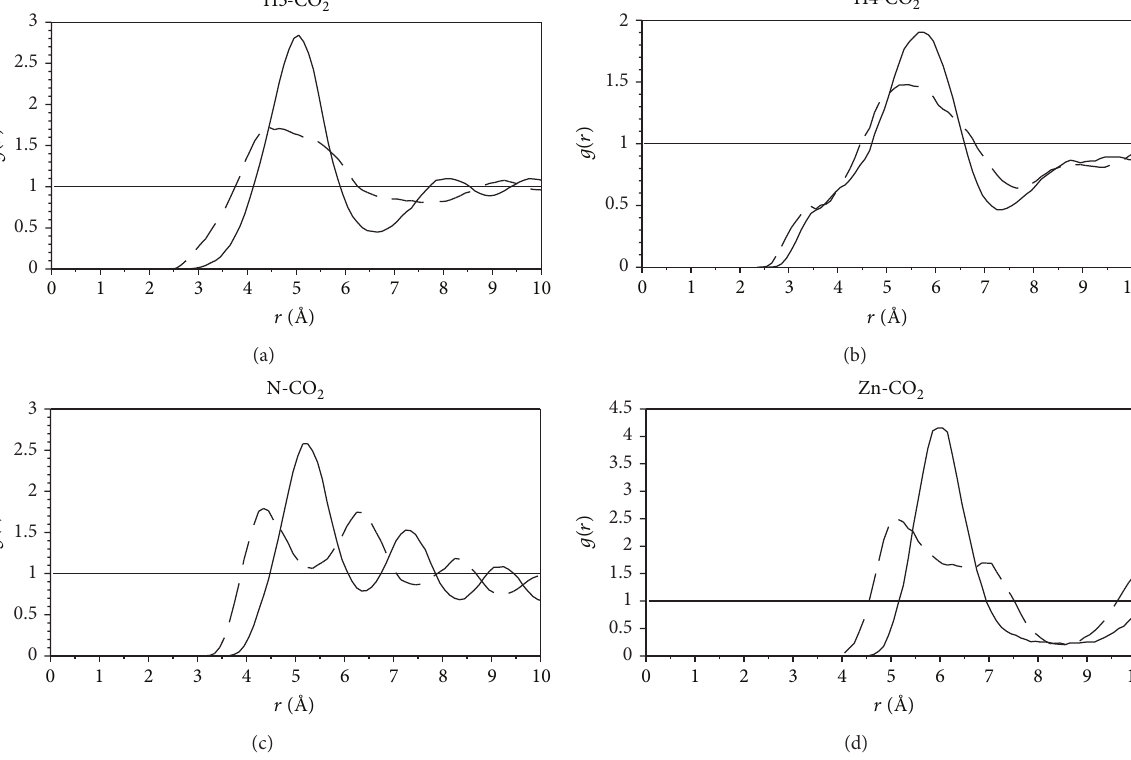
Figure 10: The obtained (a) H3-CO 2 , (b) H4-CO 2 , (c) N-CO 2 , and (d) Zn-CO 2 RDFs of SIM IV (—X–C, ––X–O) when X=H3, H4, N, and Zn,